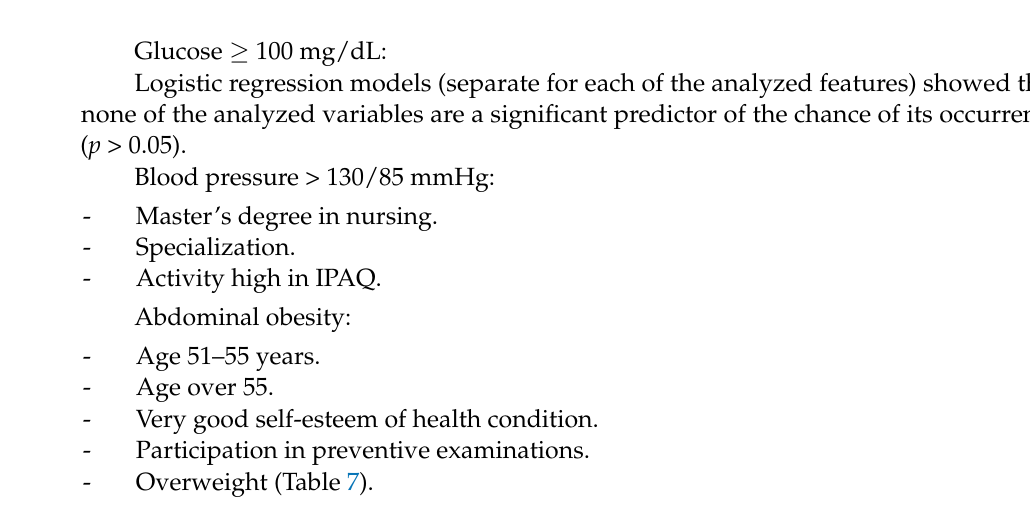
Table 7. The influence of individual variables on the occurrence of MS and MS